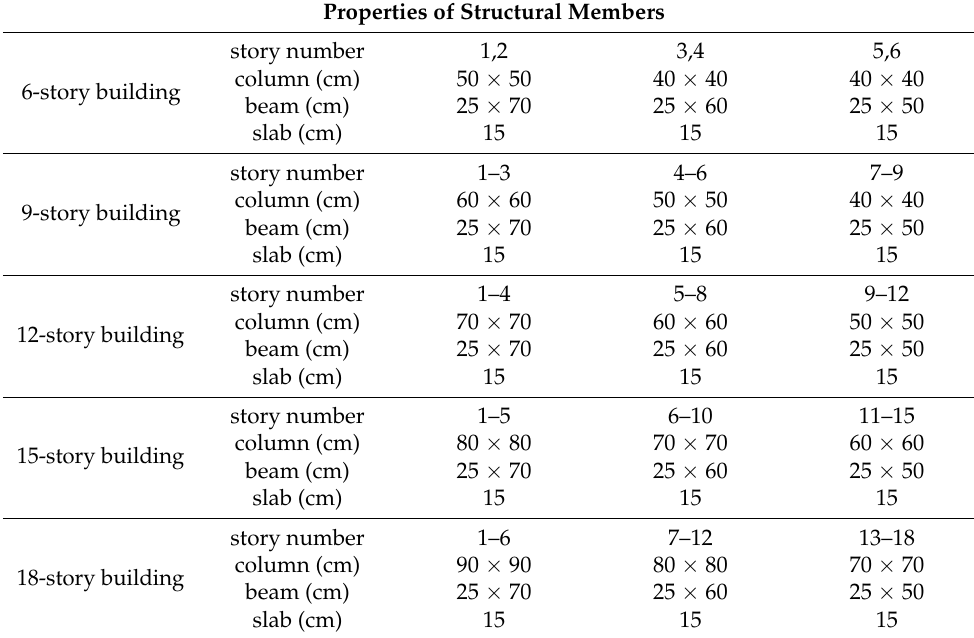
Table 3. Dimensions of structural elements.